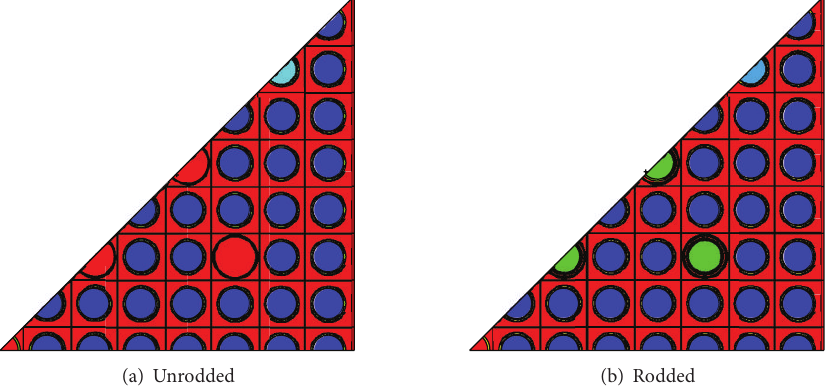
Figure 1: Geometrical model implemented in MCNPX-2.7e for 1/8 of the 15 × 15 TMI fuel assembly.